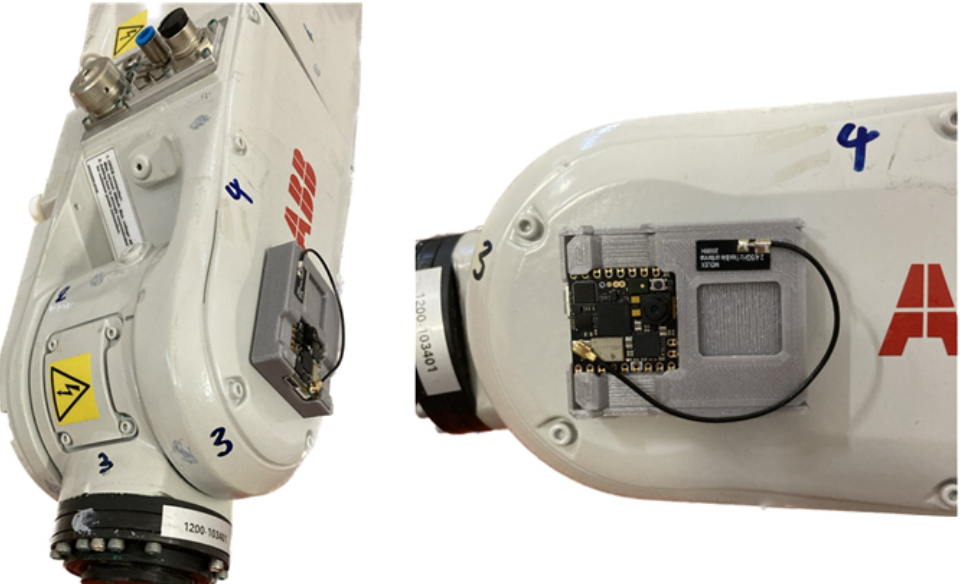
Figure 7. This figure shows the final version of the proposed embedded system mounted on an industrial robot. The device is mounted on the fifth axis of the robot, where it senses the parameters of the robot and its